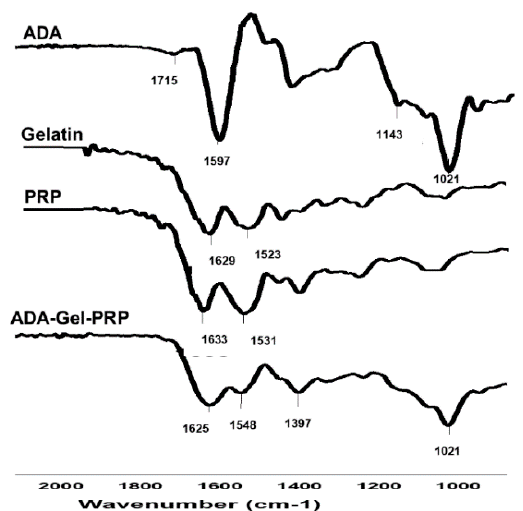
Figure 3. FTIR spectra of ADA–Gel–PRP formulation: a comparative observation of FTIR spectra of ADA, Gel, PRP, and ADA–Gel–PRP suggests successful Schiff’s base reactions, wherein aldehyde and